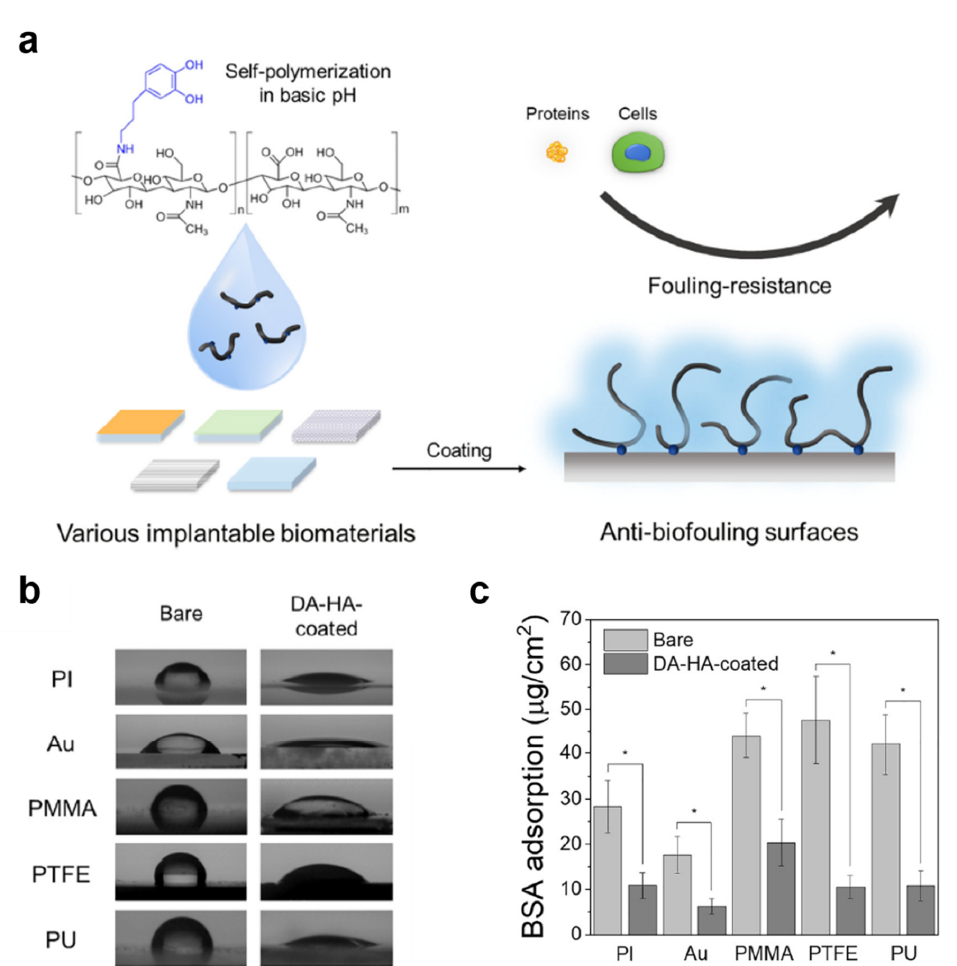
Figure 4. ( a ) Schematic illustration of HA–catechol (dopamine-conjugated HA: DA–HA) coating on various substrates (i.e., PI (polyimide), gold (Au), poly(methyl methacrylate) (PMMA), polytetrafluoroethylene (PTFE), and polyurethane (PU)) for antifouling applications. ( b ) Water contact angle measurements of various substrates before and after HA–catechol coating. ( c ) BSA (bovine serum albumin) adsorption ( µ g/cm 2 ) on bare and HA–catechol-coated surfaces after treatment with a BSA solution (1 mg/mL) at 37 ◦ C for 6 h (* p < 0.05). Reproduced with permission from [60]. Copyright © 2020